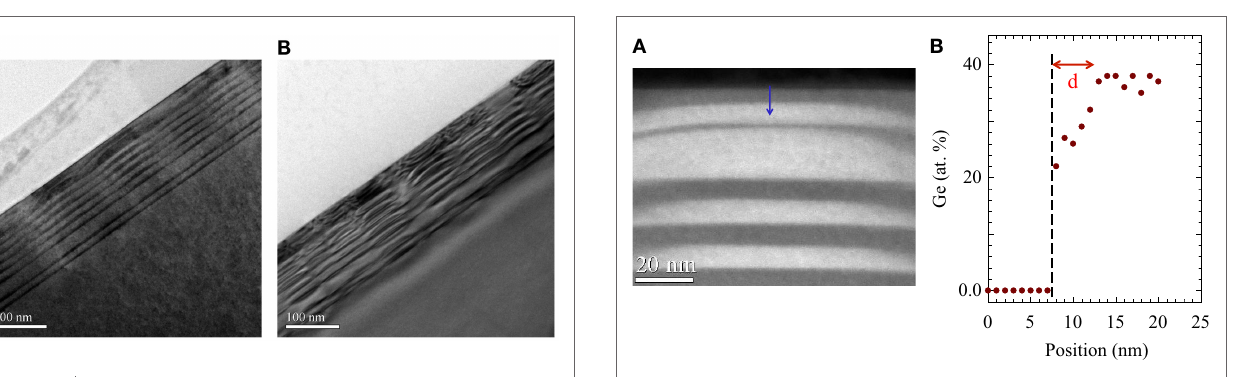
FiGURe 10 | TeM micrographs showing (A) < 011 > zone axis bright-field TeM image and (B) {200} two-beam dark-field TeM image of the specially engineered Si/SiGe cluster multilayer nanostructure . The SiGe cluster layers are clearly seen as dark areas in Figure 10 (A) (Modi et al., 2012a).